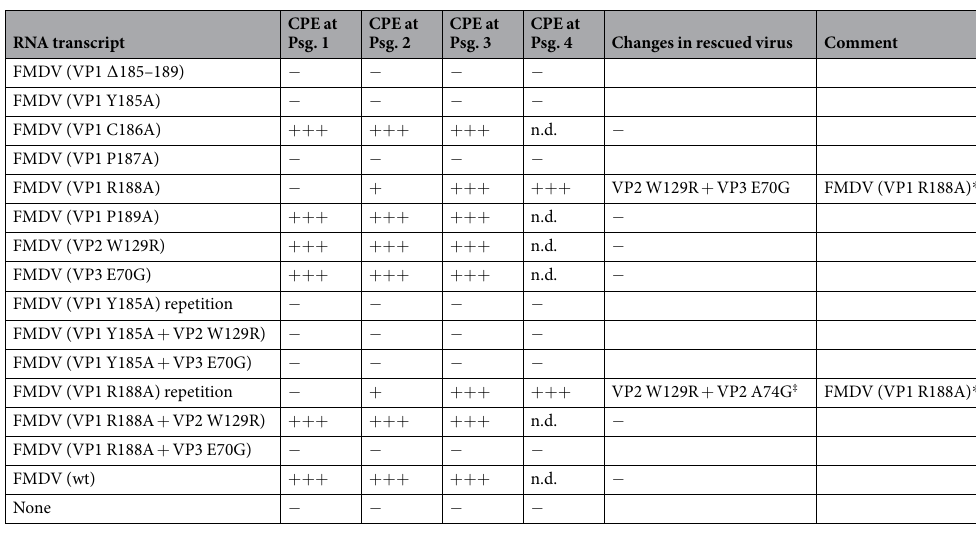
Table 1. The indicated RNA transcripts were introduced into BHK cells using electroporation. After 24 hr, the cells and medium were frozen and an aliquot of 800 µ l was added to fresh cells (passage 1). After CPE developed, or 48 hr (whichever was sooner), the procedure was repeated for passages 2, 3 and 4, however in cases of full CPE the virus aliquot for the next passage was reduced to 200 µ l. Full CPE is indicated as +++ , some CPE is indicated as + , while the absence of CPE is indicated as -, n.d. means not determined and Psg. indicates the passage number. “Repetition” indicates that a new synthesis and introduction of the RNA into cells was performed. ‡ : In 12/15 clones sequenced the VP2 A74G change was present, while in 1/15 clones